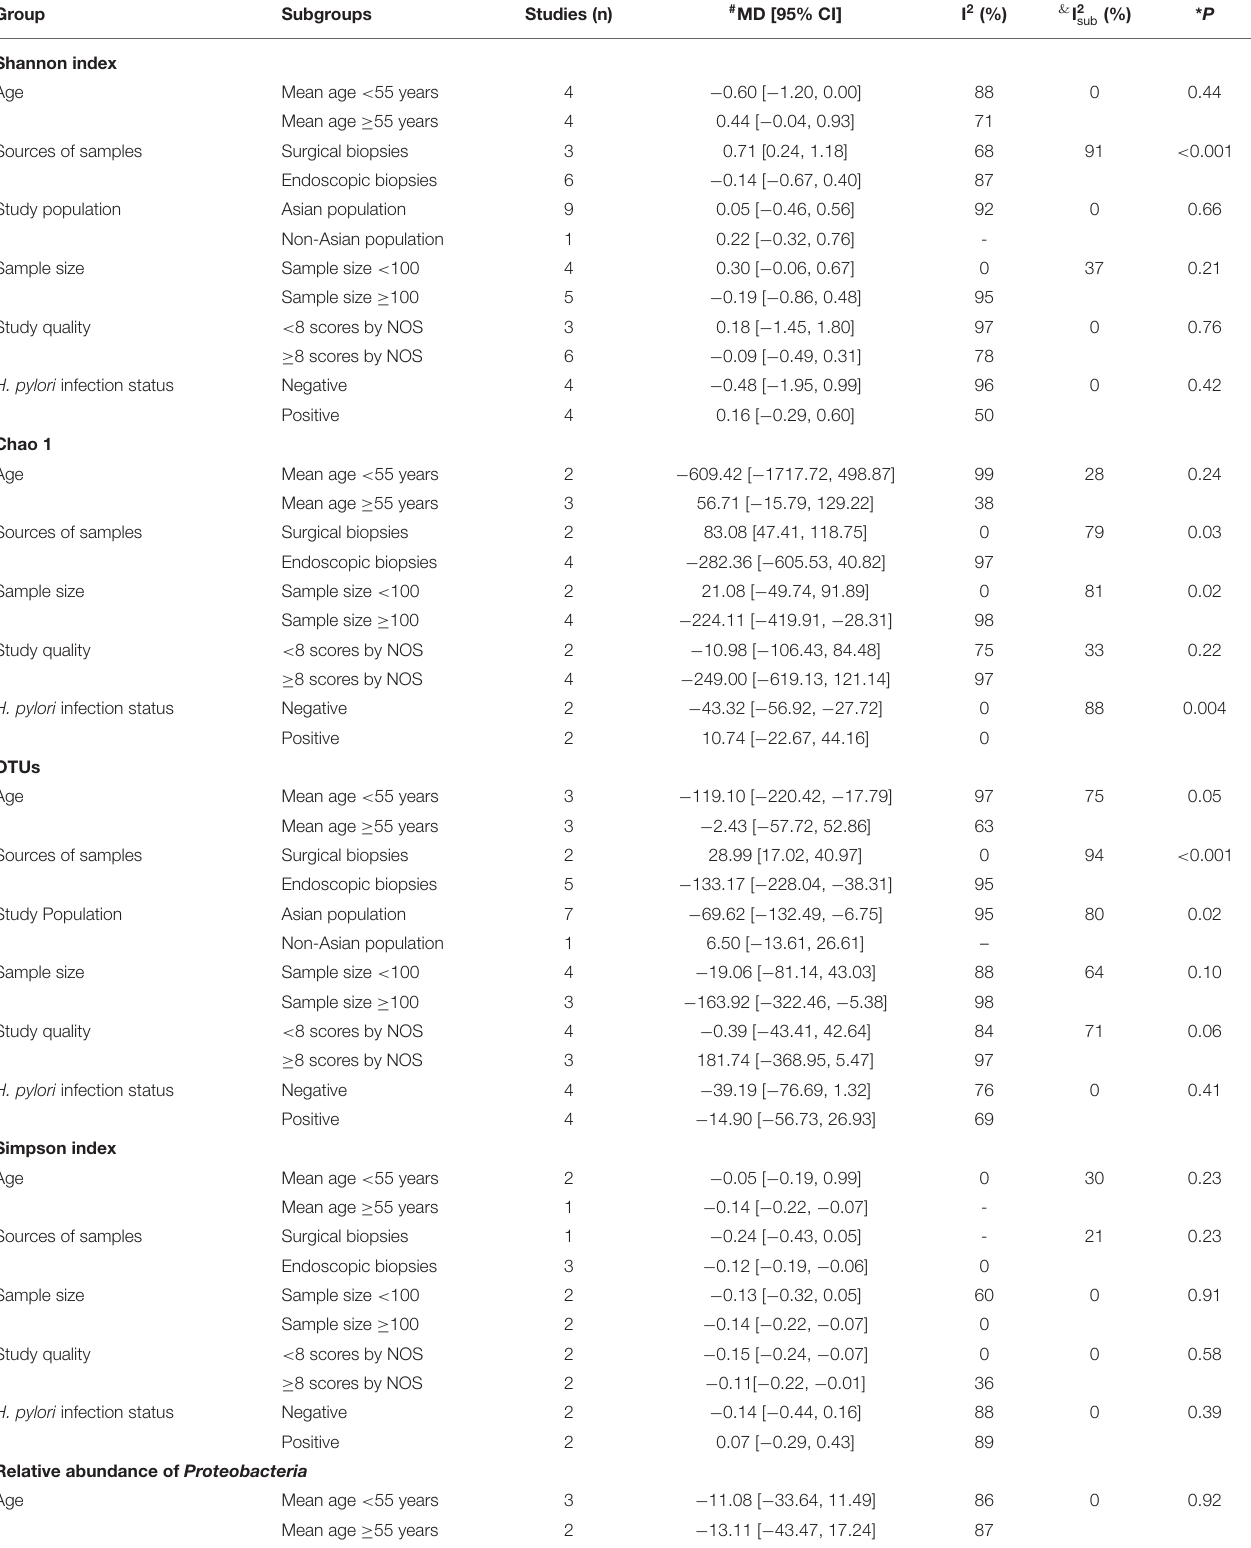
TABLE 3 | Subgroup analyses and univariate meta-regression analyses of changes in alpha diversity indexes and relative abundance of bacterial phyla.